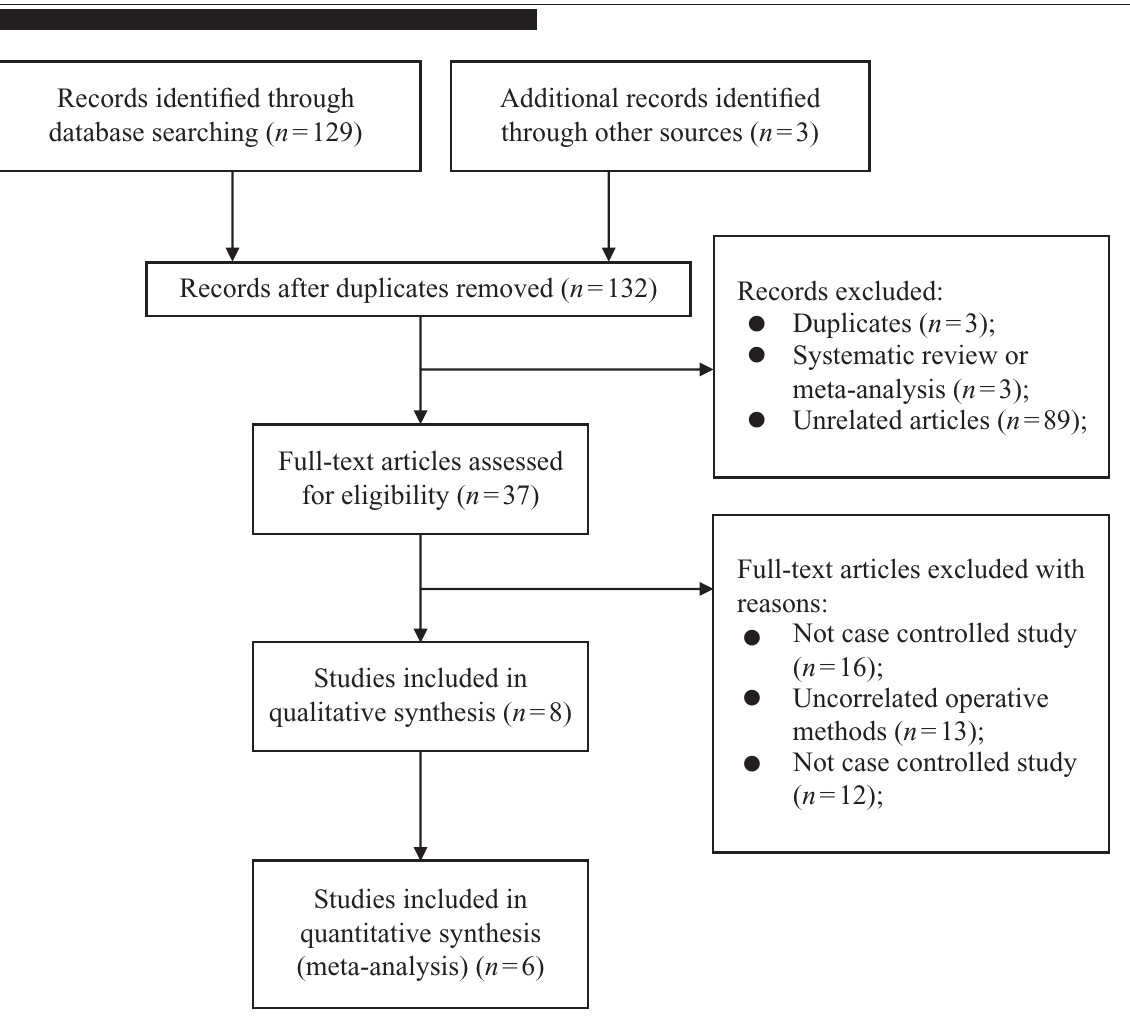
Figure 1. Flow diagram of search